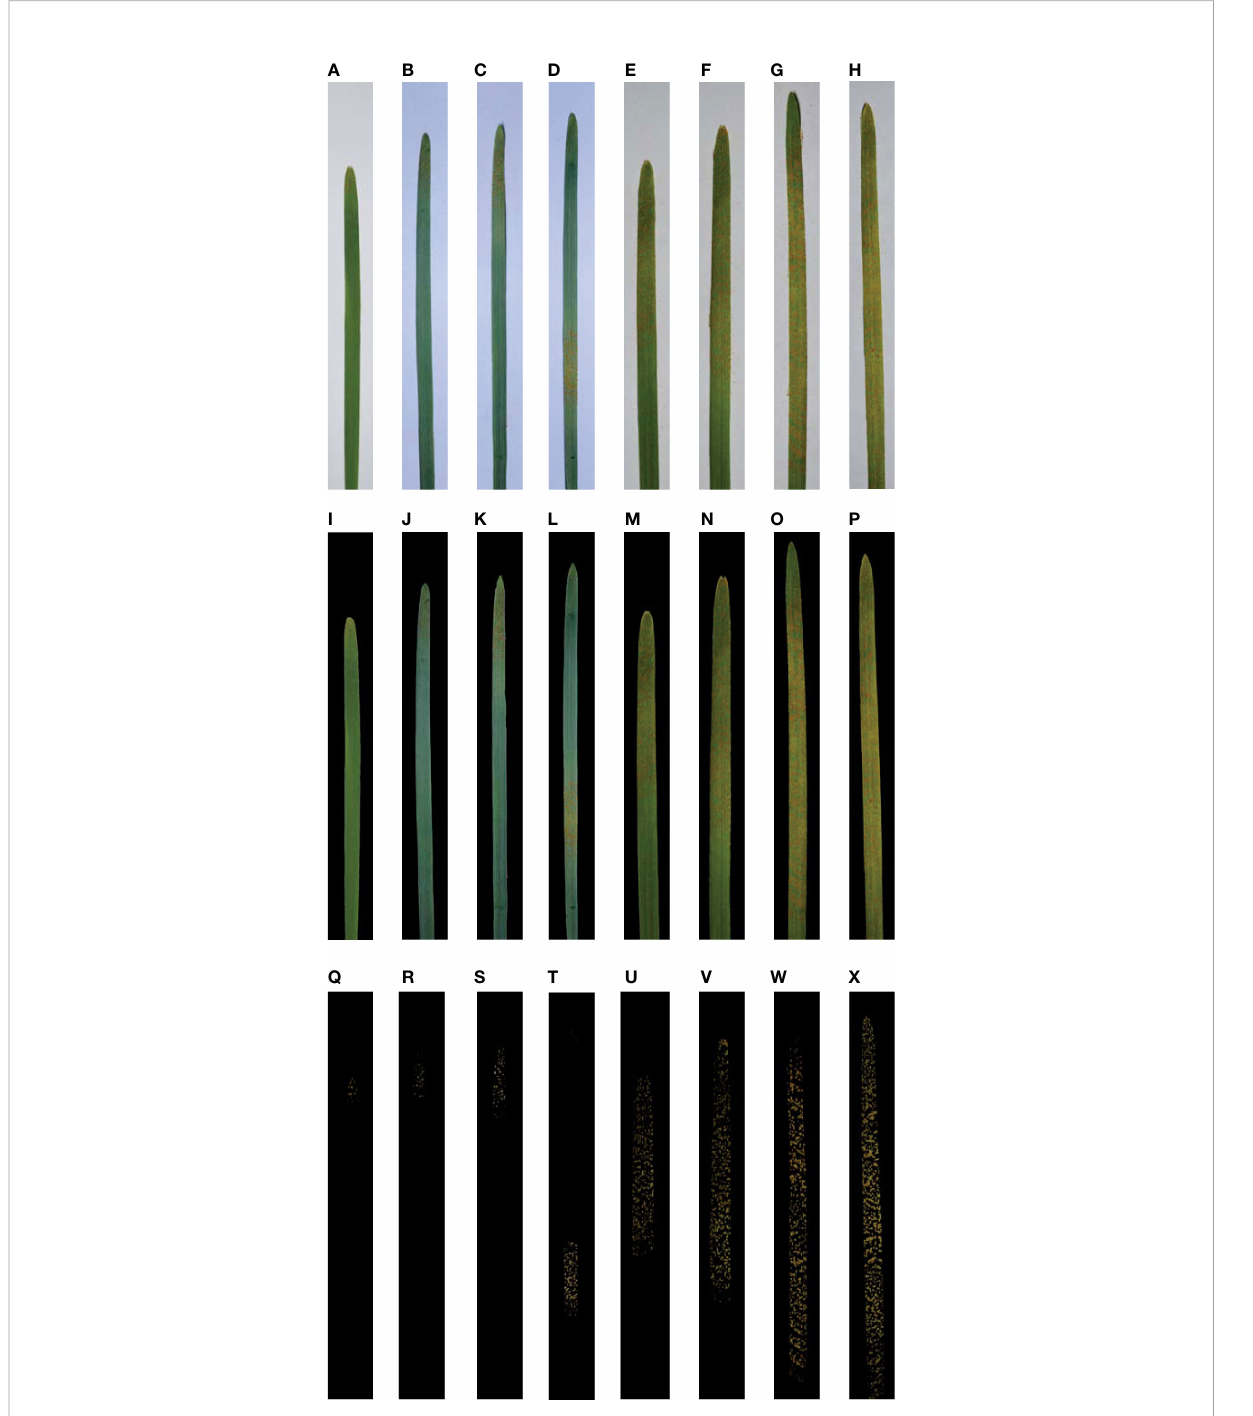
FIGURE 2 Single wheat leaf images of each severity class of wheat stripe rust and the corresponding leaf region images and lesion images after segmentation. All the images were shown after being cropped uniformly so that they could be demonstrated clearly. (A – H) Single diseased wheat leaf images of the severity classes of 1%, 5%, 10%, 20%, 40%, 60%, 80%, and 100%, respectively; (I – P) Segmented images of leaf regions for the single diseased wheat leaf images of the severity classes of 1%, 5%, 10%, 20%, 40%, 60%, 80%, and 100%, respectively; (Q – X) Segmented lesion images for the single diseased wheat leaf images of the severity classes of 1%, 5%, 10%, 20%, 40%, 60%, 80%, and 100%,